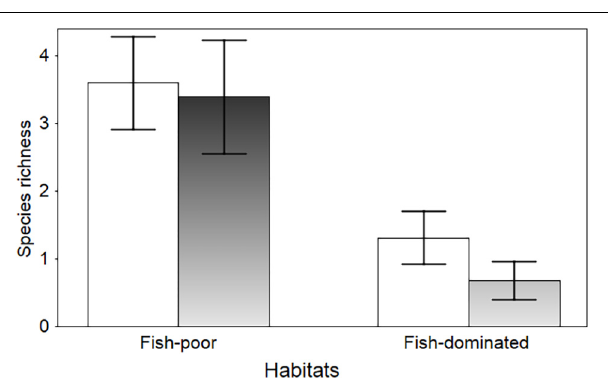
FIGURE 2 | Anuran species richness based on spawn surveys (open bars) and on trapping of tadpoles (filled bars) in fish-poor and fish-dominated ponds. Data shown are means and ± 95% confidence